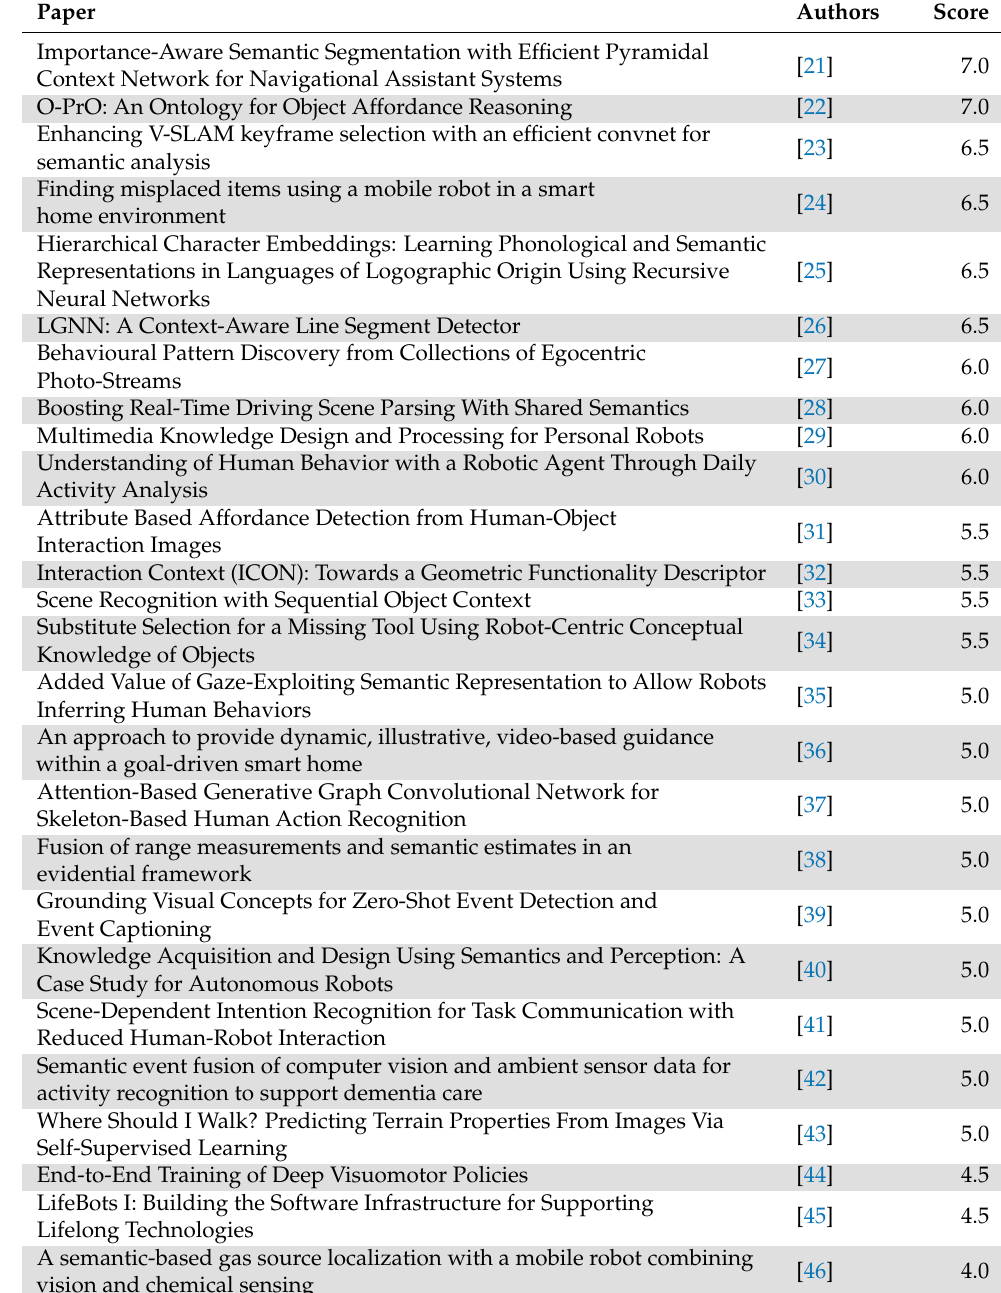
Table 5. Attributed quality scores for each of the approved works in decreasing